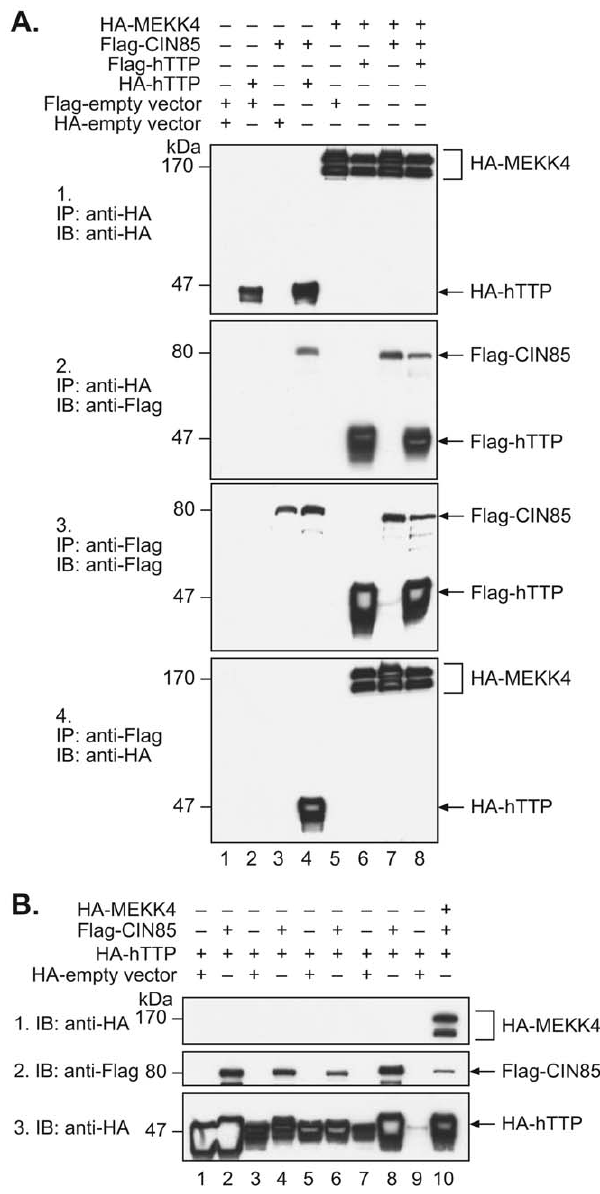
Figure 6. Interaction between hTTP and both MEKK4 and CIN85. In A, tagged expression constructs of MEKK4, CIN85 and hTTP were co-transfected in pairs (lanes 1 to 7) or together (lane 8) with or without empty vectors. Abbreviations and other details are as described in the legend to Fig. 1. In B are shown whole cell lysates, demonstrating the protein expression from the various expression plasmids or empty vectors, as well as the apparent shift in the M r of hTTP when co- expressed with